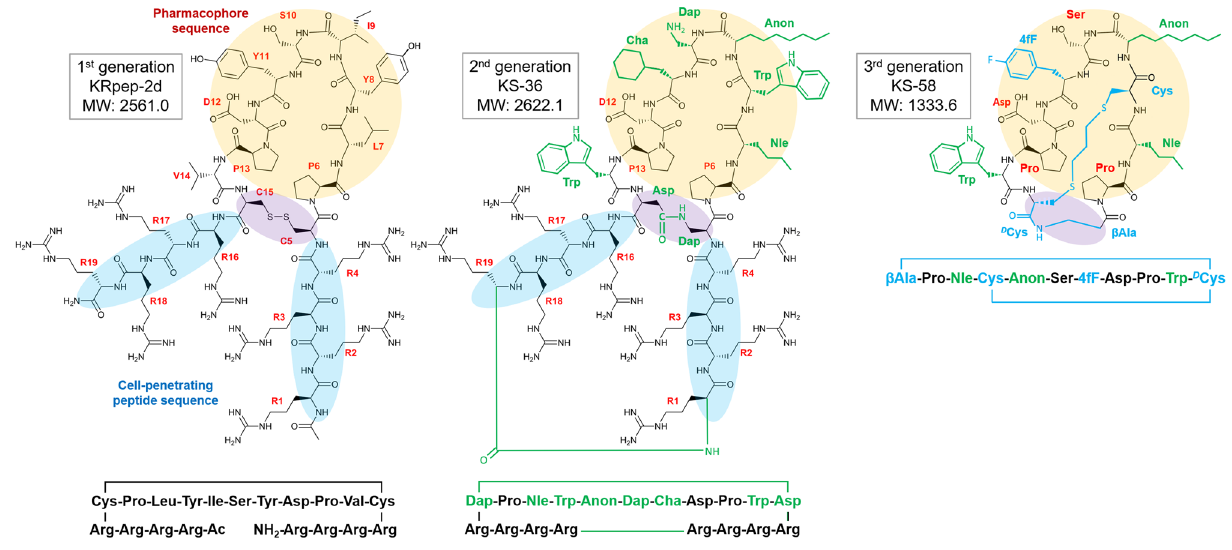
Figure 1. Chemical structures of KRpep-2d, KS-36, and